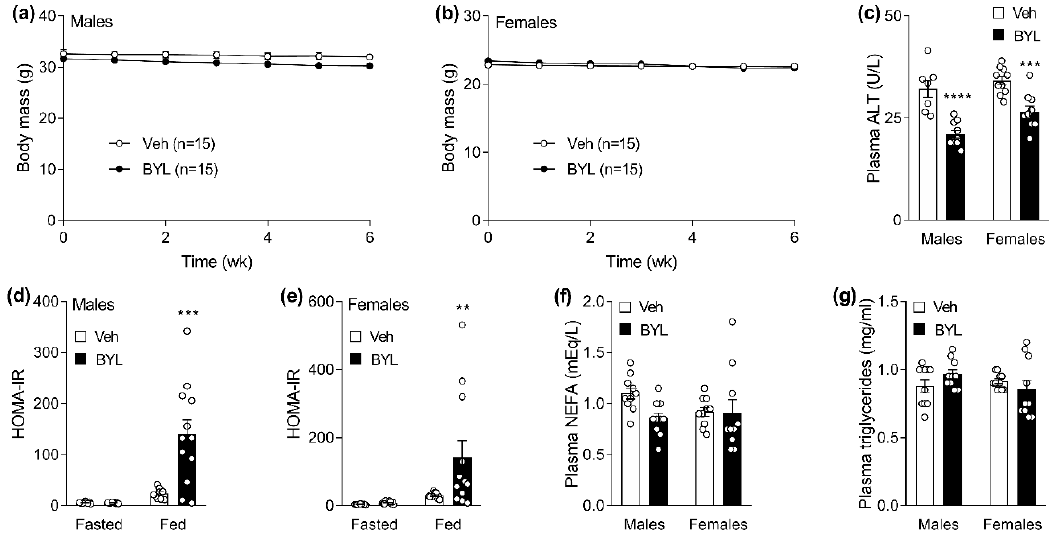
Figure 4. Body mass ( a , b ), plasma alanine aminotransferase (ALT) ( c ), HOMA-IR ( d , e ), and plasma non-esterified fatty acids (NEFA) ( f ) and triglycerides ( g ) of male and female middle-aged mice following 6 weeks of receiving a control- (Veh; vehicle) or BYL719 (BYL)-containing diet. Data are presented as mean ± SE, statistical analysis for was by two-way repeated measures ANOVA ( a , b ) and two-way ANOVA ( d , e ) with a Sidak post-hoc and/or t -test ( c , f , g ). ** p < 0.01, *** p < 0.001, **** p < 0.0001 vs. Veh, n = 6 per group for ( a – d ).